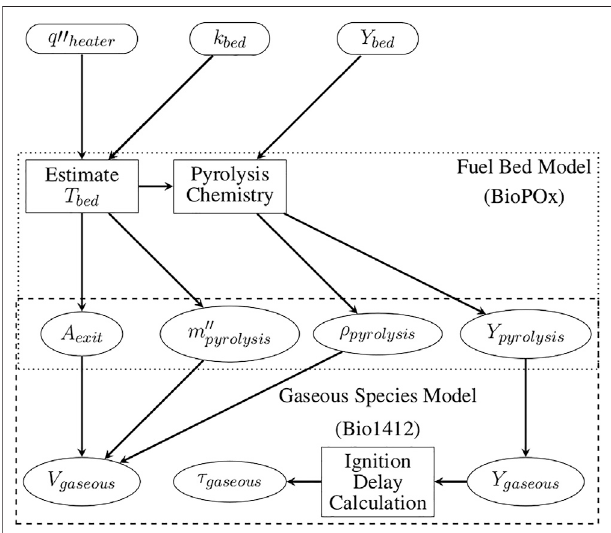
FIGURE 3 | Illustration of the model used for the estimated heater fl ux (q ″ heater ), thermal conductivity of the fuel bed ( k bed ), and chemical composition of the fuel bed ( Y bed ), (e.g., cellulose) to calculate temperature ( T ) and pyrolyzate distribution above the fuel bed, and determine the resulting ignition delay times( τ ). Here the subscript bed represents the propertiesof the fuel bed materials and pyrolysis represents the pyrolysis products leaving the fuel bed and entering the air above the fuel bed. For example, V pyrolysis represents the velocity of pyrolysis gases leavingthe fuelbed and entering the quiescent air